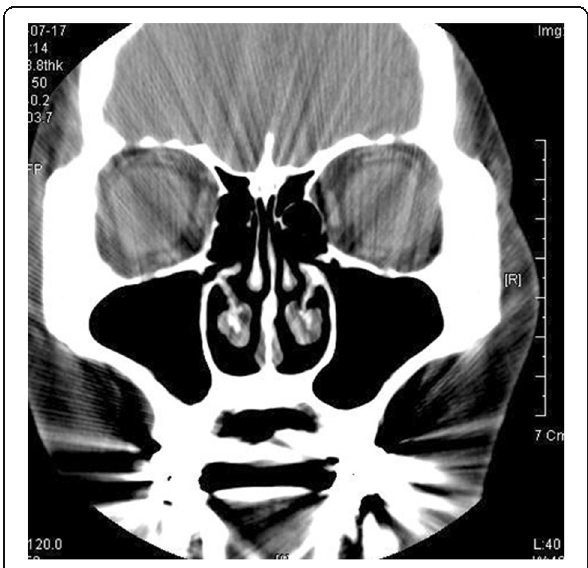
Fig. 4 Computed tomography (CT) view at 3.5 months follow-up. Radiolucency is shown on both sinuses and all clinical symptoms of right side sinusitis have been